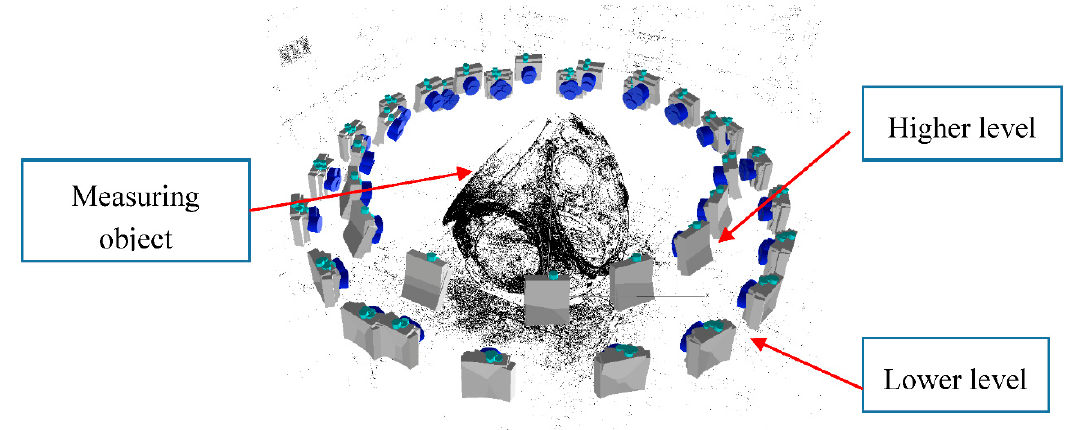
Figure 7. Camera shooting technique around the part.